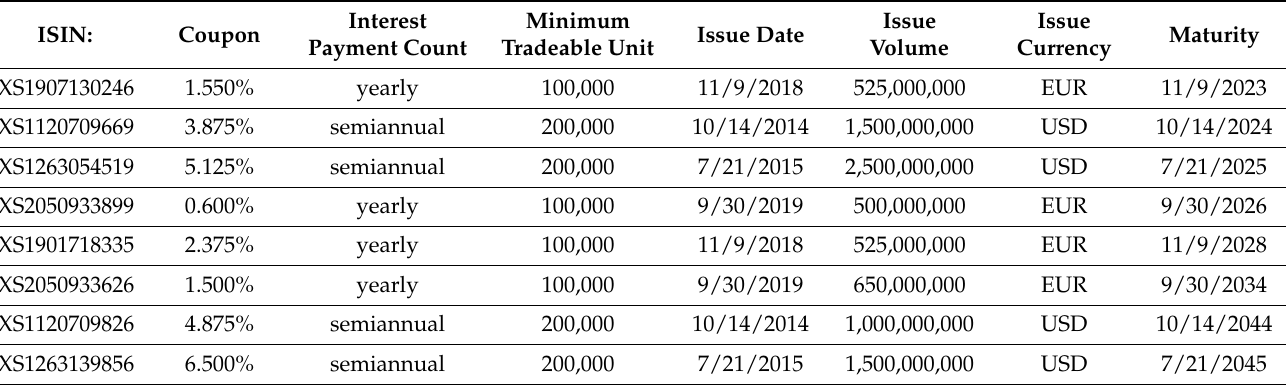
Table 11. Kazakhstan’s Sovereign Bonds parameters.